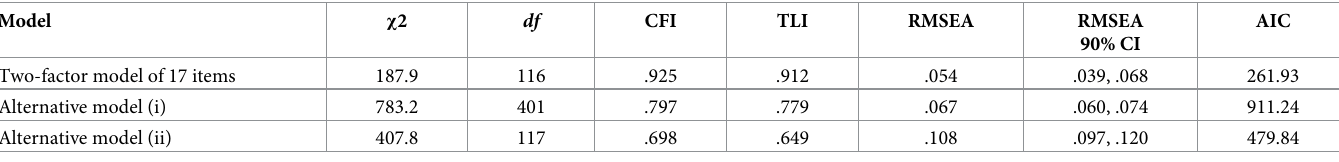
Table 2. Fit statistics of the hypothesized and the alternative models for the Mediterranean countries.